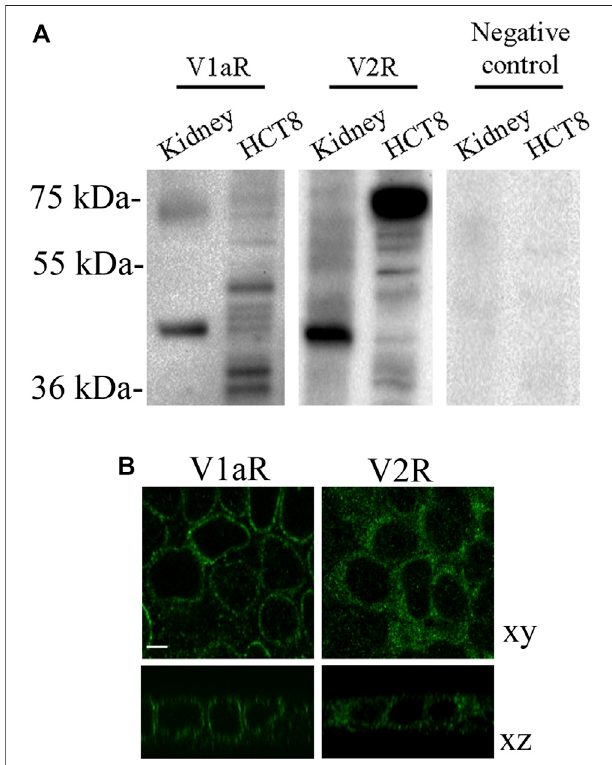
FIGURE 1 | Endogenous expression and localization of vasopressin receptors in HCT8 cells. (A) An equal amount of proteins (60 µg) of total homogenates from HCT8 cells were blotted and probed with the indicated antibodies. Immunodetection revealed that V1aR and V2R are expressed in this cell model. Mouse kidney homogenates were used as a positive control. (B) Representative confocal images of immuno fl uorescence studies show that HCT8 cells express V1aR and V2R endogenously. Bar = 10